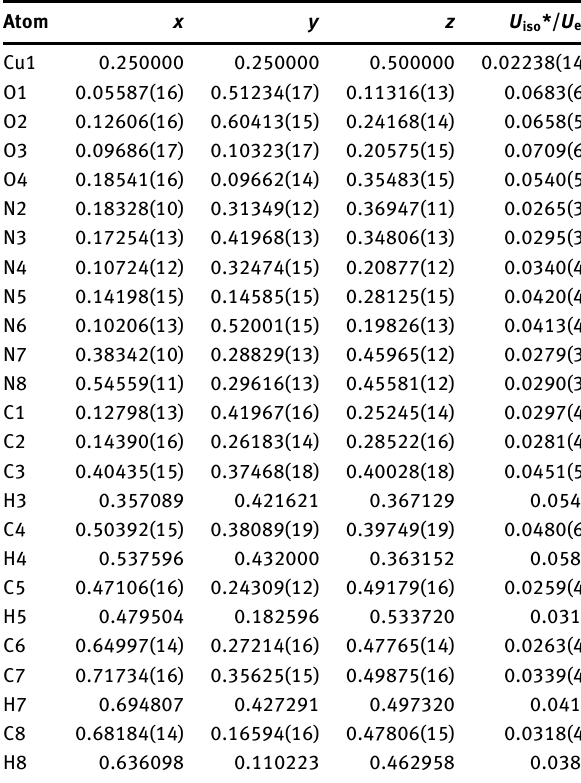
Table 2: Fractional atomic coordinates and isotropic or equivalent isotropic displacement parameters (Å 2